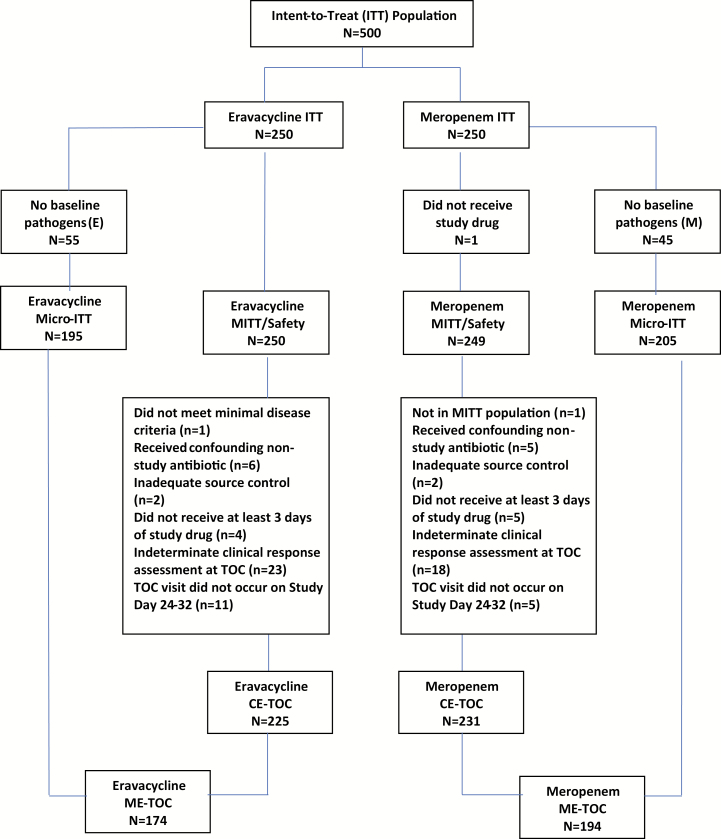
CONSORT diagram. Abbreviations: CE, clinically evaluable; ME, microbiologically evaluable; micro-ITT, microbiological intent-to-treat; MITT, modified intent-to-treat; TOC, test-of-cure.